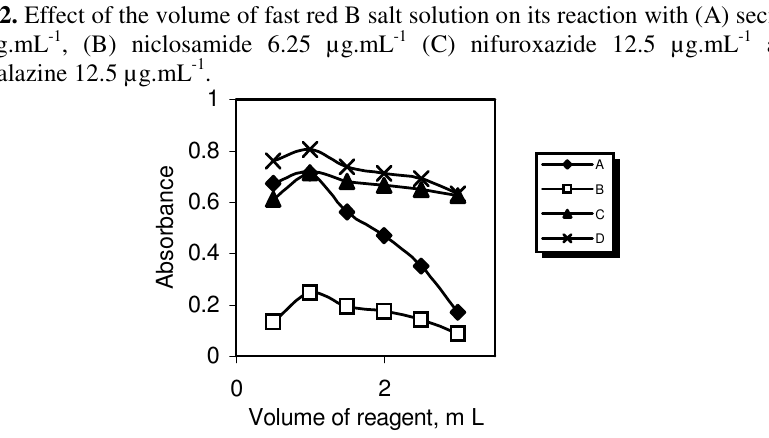
Figure 3. Effect of the volume of sodium hydroxide solution on the reaction between fast red B salt and (A) secnidazole 12.5 µg.mL -1 , (B) niclosamide 6.25 µg.mL -1 (C) nifuroxazide 12.5 µg.mL -1 and (D) sulphasalazine 12.5 µg.mL -1 .